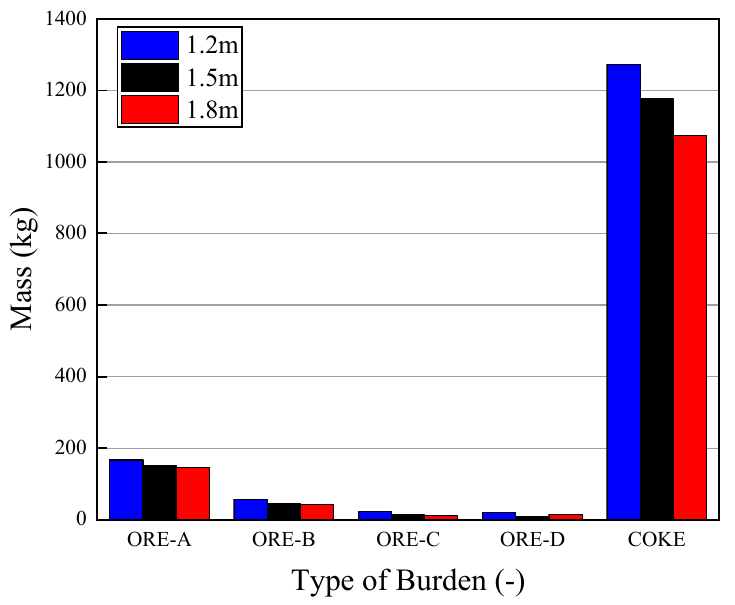
Figure 8. Distribution of burden in sampling area under di ff erent burden line depths.